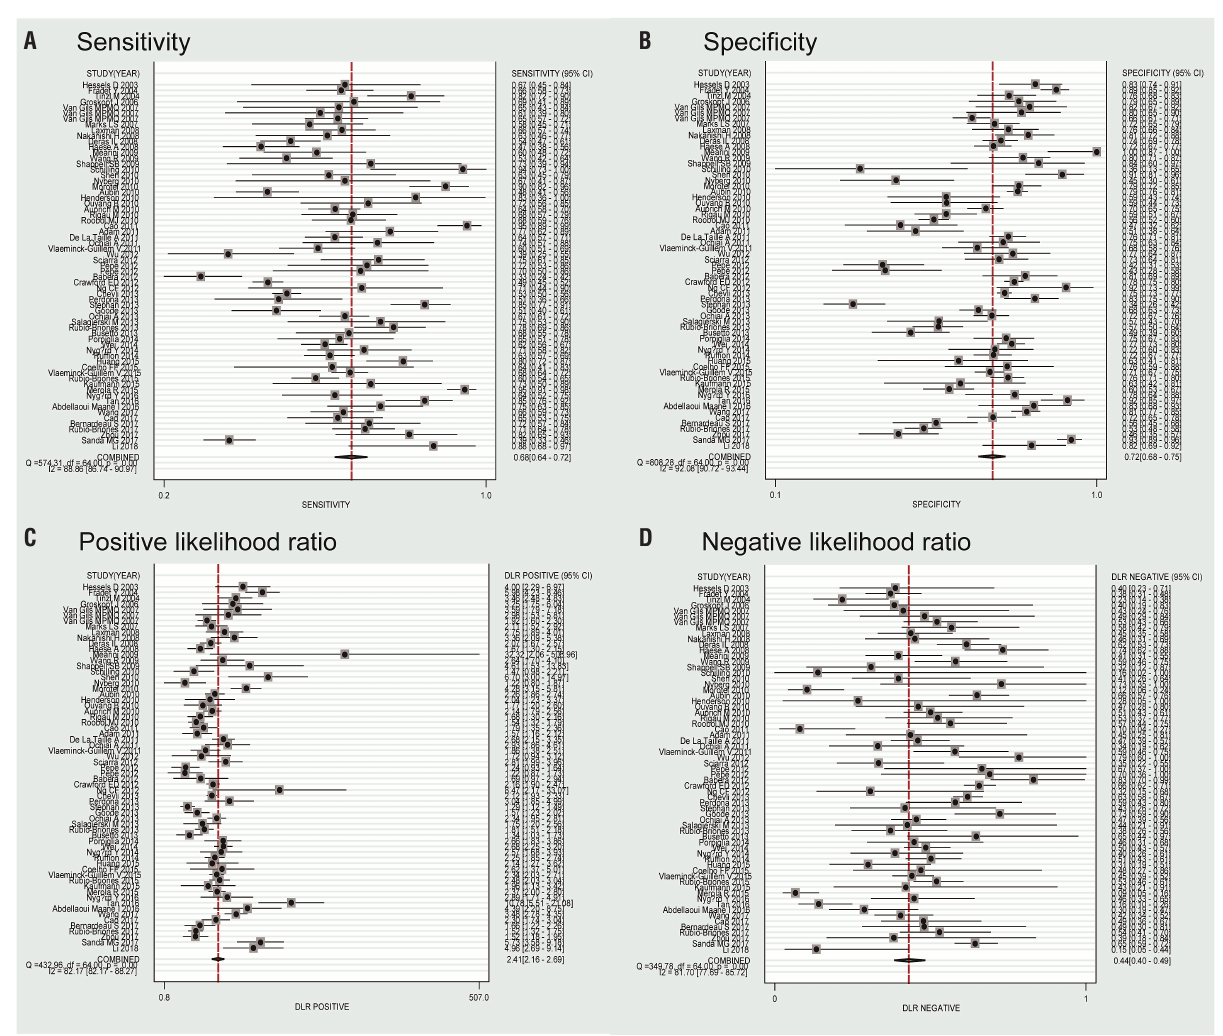
Figure 2 - Flowchart of literature search and selection